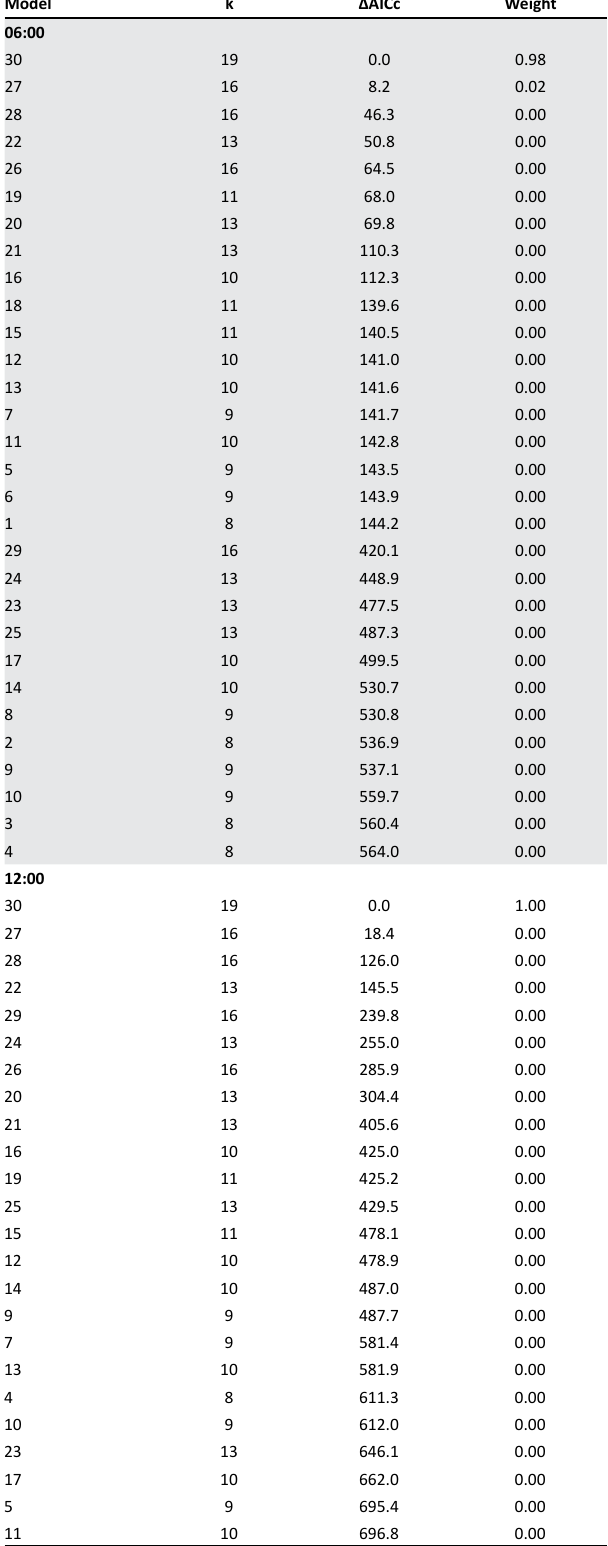
TABLE 2: Model selection results for elephant resource selection at a daily scale in Addo Elephant National Park, South Africa. Daily selection was considered